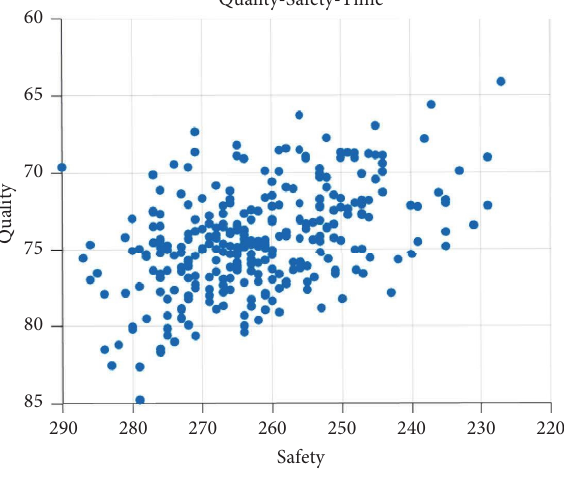
Figure 20: Quality-safety trade-of.